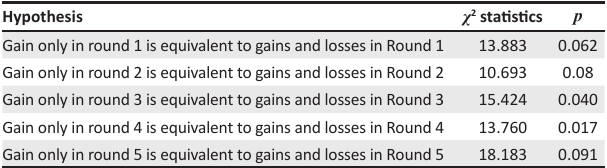
TABLE 2: Chi-square test of association. Hypothesis χ 2 statistics p